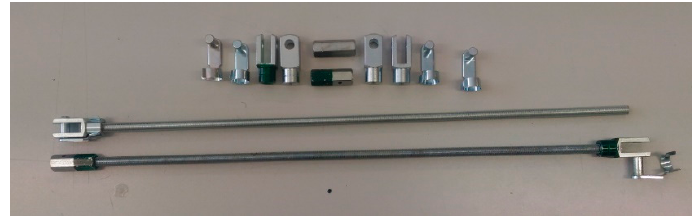
Figure 16. Bending pressure system set. Simple and economical system formed by two threaded rods with normal and reverse threads that allow us to achieve the necessary torque to bend the mirrors.